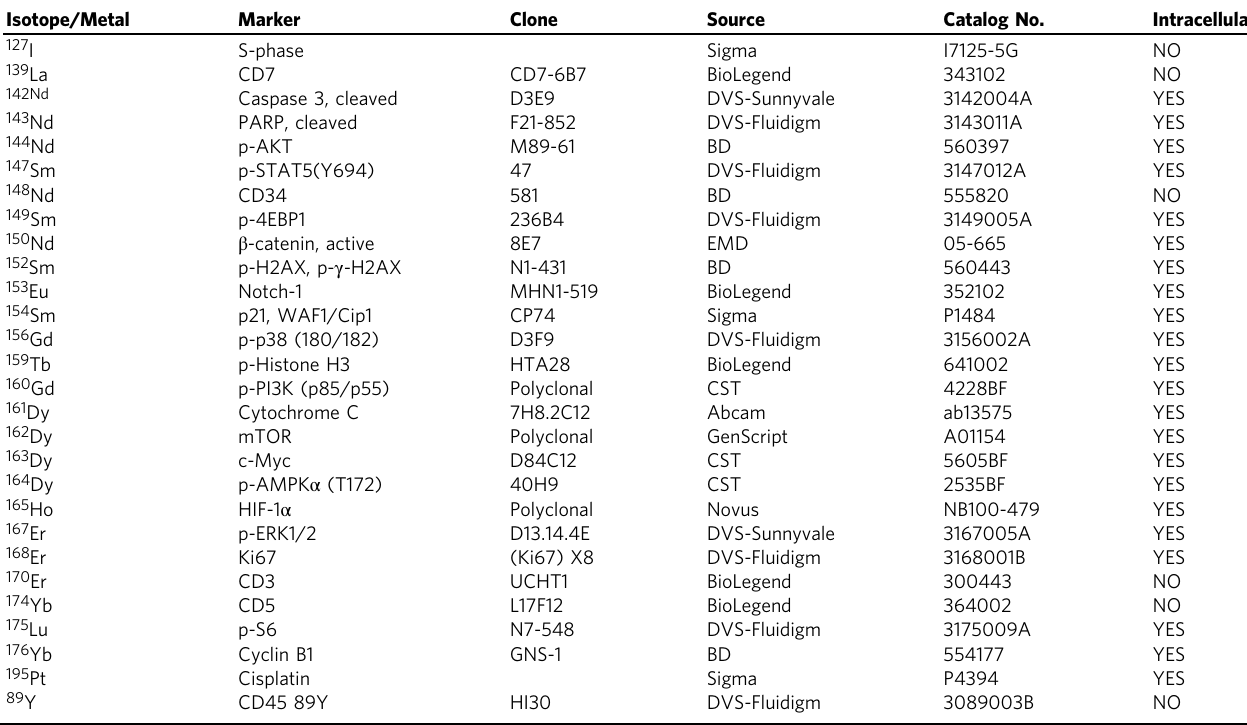
Table 4 Panel of antibodies used for CyTOF